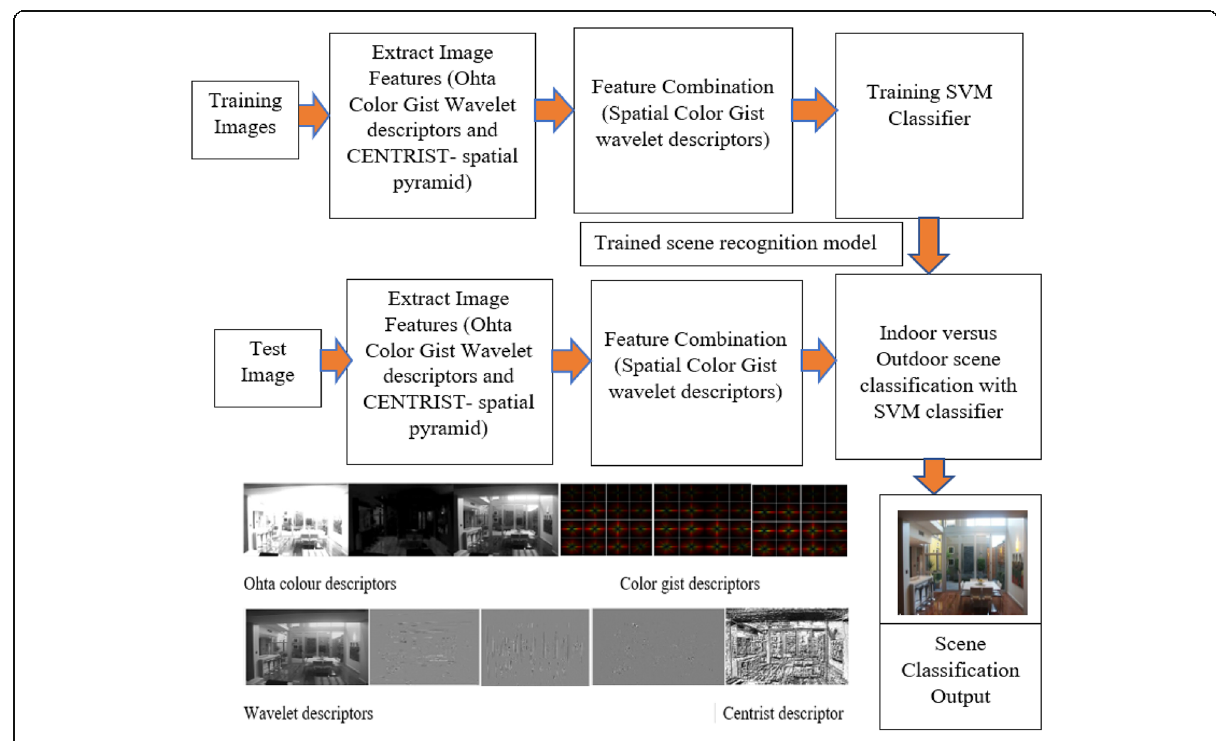
Fig. 6 The block diagram of the proposed